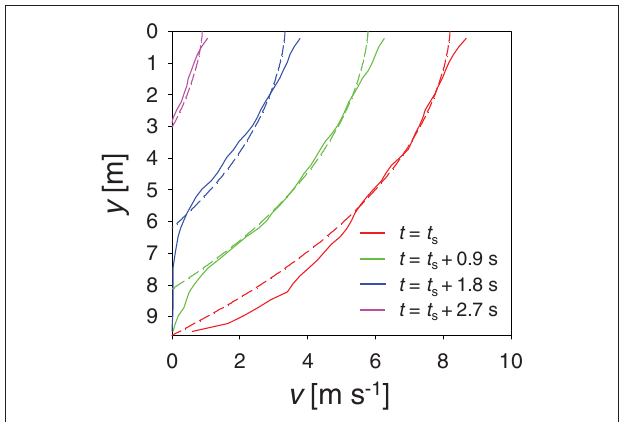
FIGURE 4 | Velocity profiles at various time instants during deceleration of the h = 9.6 m thick slide on a flat plane. Simulation results (solid lines) are compared to the analytical prediction (dashed lines) after Equation (16). The flow depth is gradually reduced.